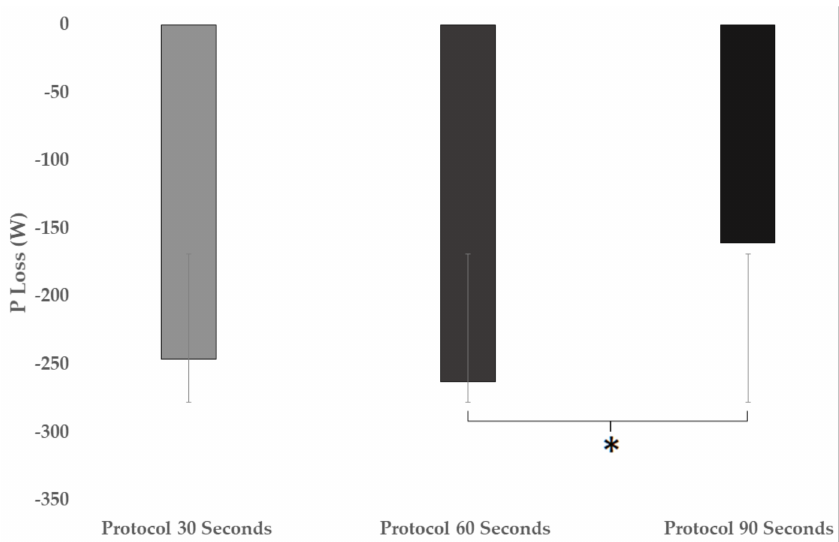
Figure 4. Loss power comparison developed in different HIIT protocols. * means significant difference.